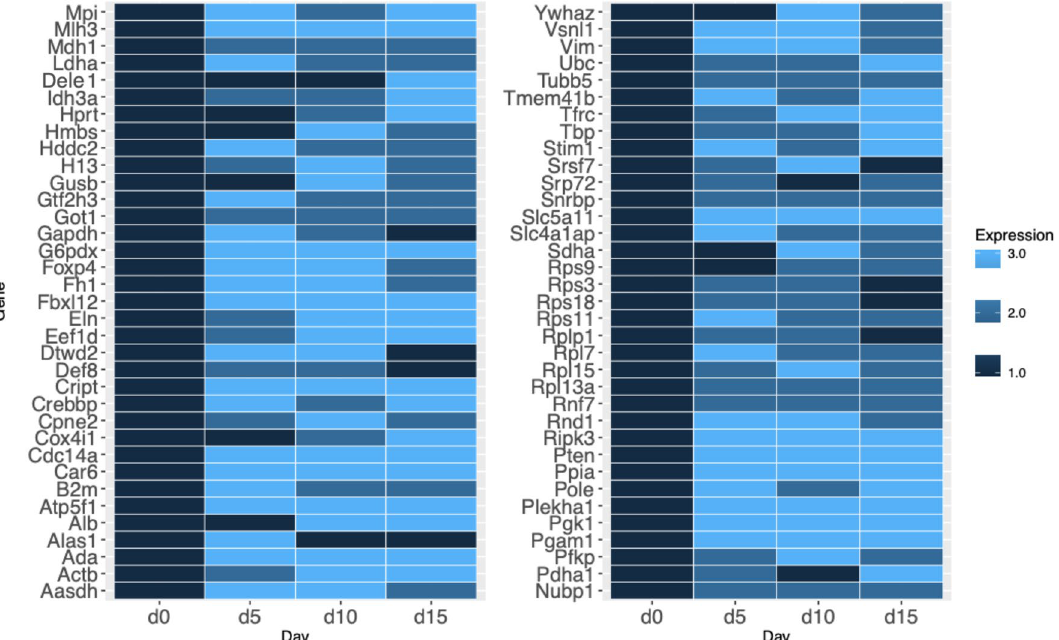
Figure 3. A heatmap representing fold changes in the housekeeping genes’ expressions throughout the iPS reprogramming process. The genes are grouped by fold-expression change into one of three groups, represented by dark blue, medium blue and light blue. Four time points during the reprogramming are indicated under the heatmaps, and the gene names are written on the left. The dark blue color represents no expression change, and Day 0 is taken as the “time point zero” before initiation of reprogramming. The medium blue color represents the expression change of more than statistically significant 1.5-fold, but less than threefold. Light blue represents gene expression change greater than threefold, compared to time point zero (Day 0).